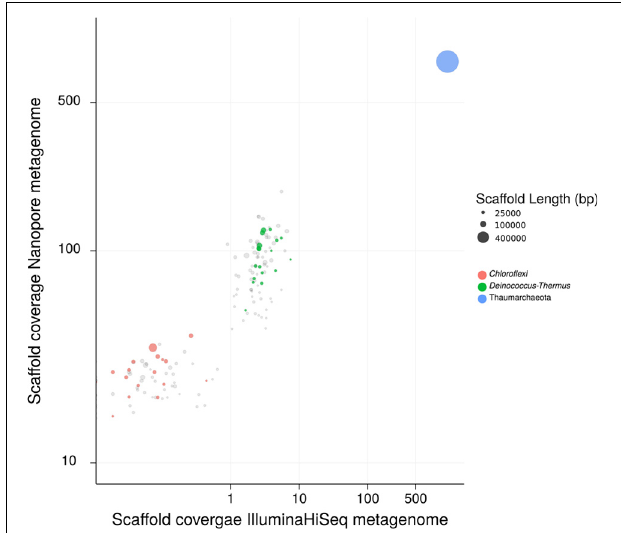
FIGURE 4 | Sequence composition-independent binning of the metagenome scaffolds from two ammonia-oxidizing enrichment cultures. Circles represent scaffolds, scaled by the square root of their length. Clusters of similarly colored circles represent potential genome bins. The x -axis shows binning of the scaffolds from an early enrichment culture, which still included other genera as well (not shown). The y -axis shows binning of the scaffolds from the latest enrichment culture containing only “ Ca. N. islandicus” and the two remaining accompanying organisms. Genome bins for the Thermus (34% complete) and the Chloroflexi (56% complete) organism were obtained. The genome bin of the Chloroflexi organism contains genes that cluster within a clade of Nitrobacter / Nitrolancea nitrite oxidoreductase ( nxrAB ) genes (data not shown). Some nitrate production by the batch enrichment culture was observed after multiple re-feedings with NH 4 + ( > 20 mM). As NOB in the phylum Chloroflexi are known (Sorokin et al., 2012), it is tempting to speculate that this Chloroflexi may be a thermophilic nitrite oxidizer.